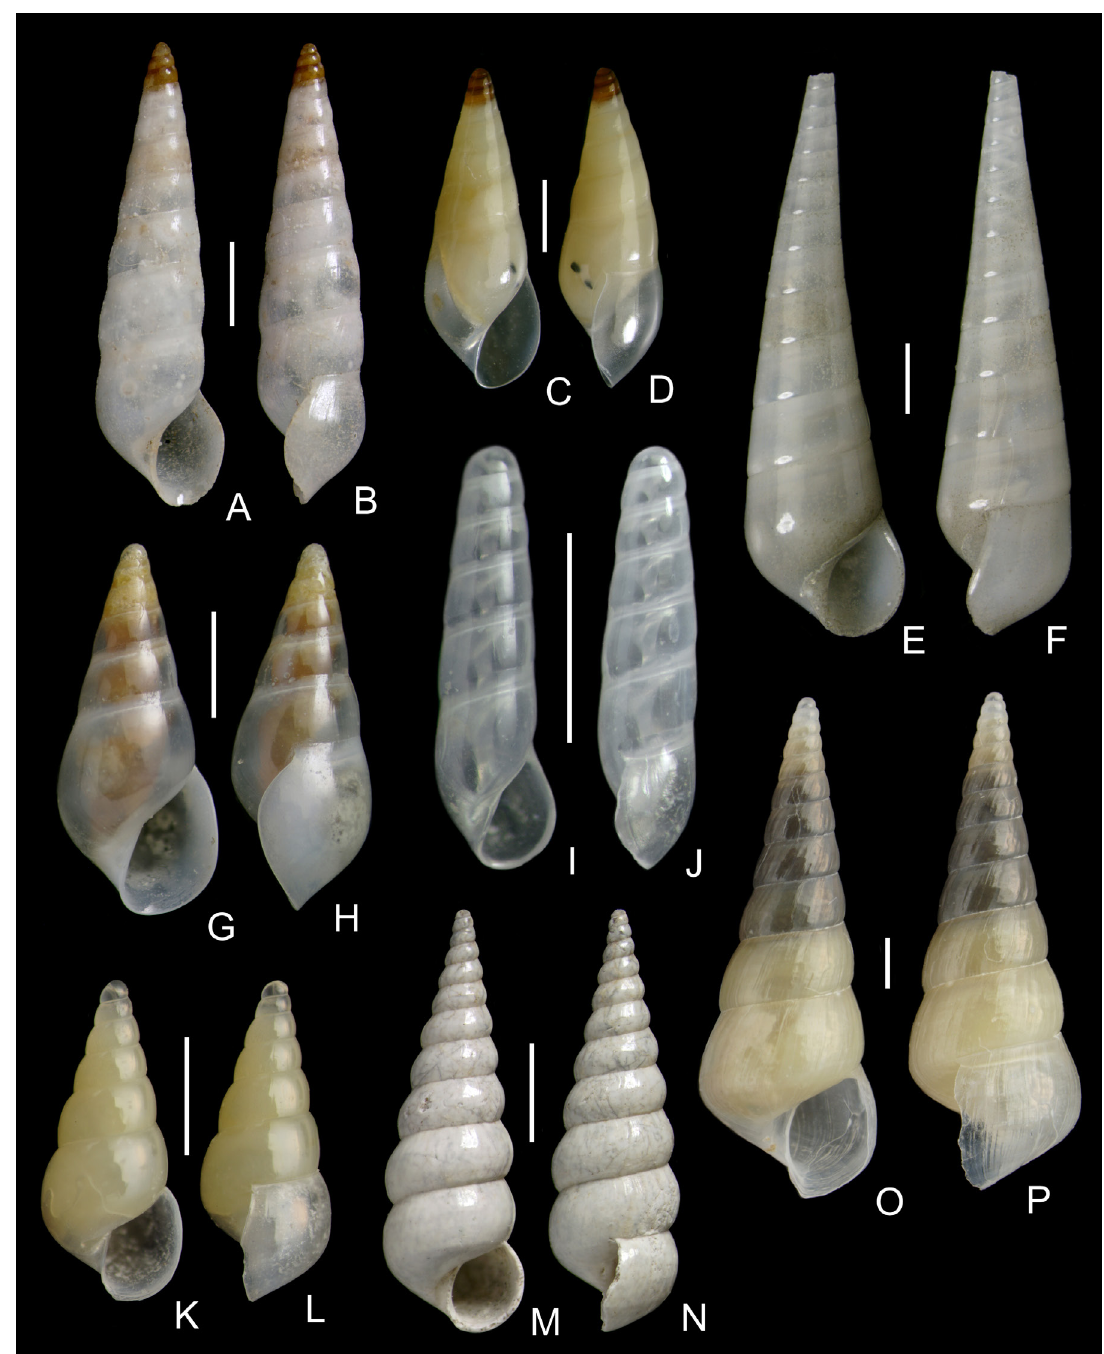
Fig. 20. Eulimidae 2. A–B . Batheulima fuscoapicata (Jeffreys, 1884), BANGAL 0711,